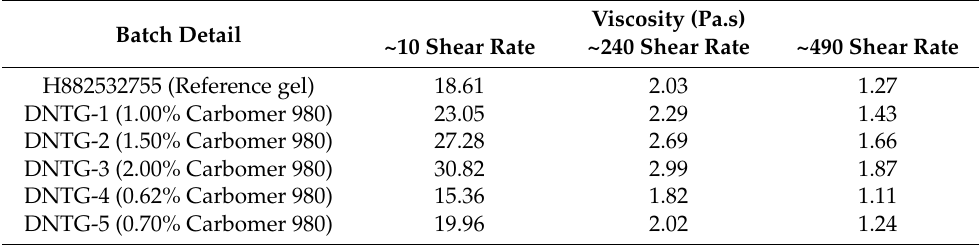
Table 3. Viscosity data at low, medium, and high shear rates for reference gel and niosomal gel formulations containing different concentrations of Carbomer